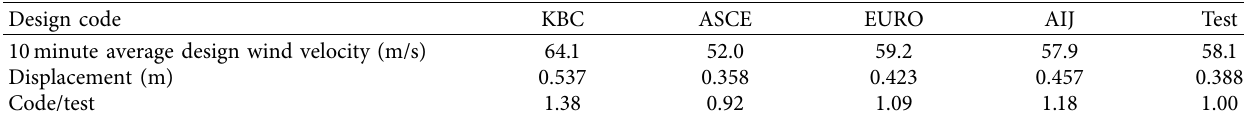
Table 5: Maximum along-wind displacements at basic wind velocity of